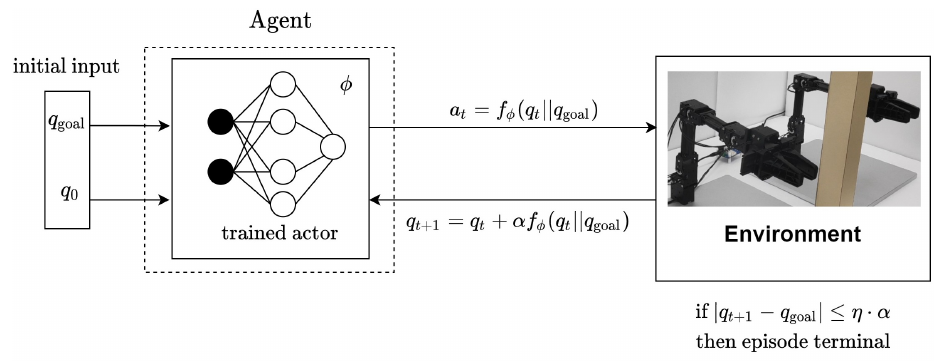
Figure 9. Path generation using the trained actor DNN.